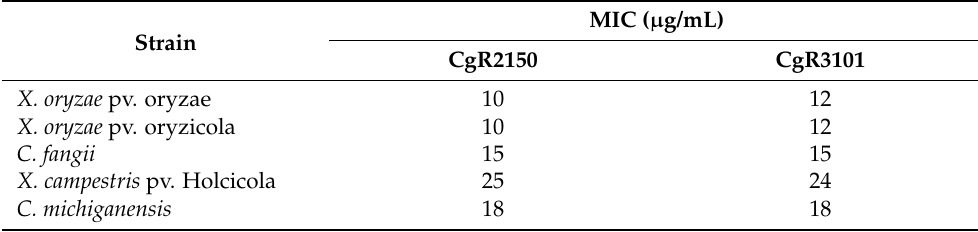
Table 4. MIC values ( µ g/mL) of CgR2150 and CgR3101 against different bacteria.